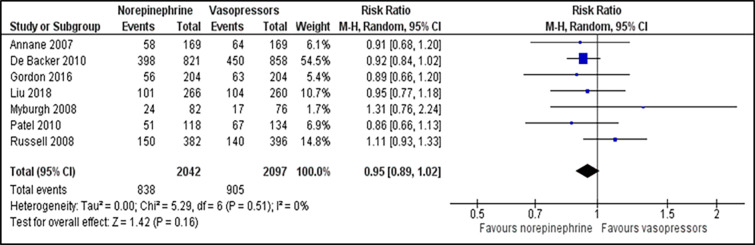
Comparison between norepinephrine and vasopressors for the outcome of the number of participants with all-cause 28-day mortality.M-H, Mantel-Haenszel method; CI, confidence interval.